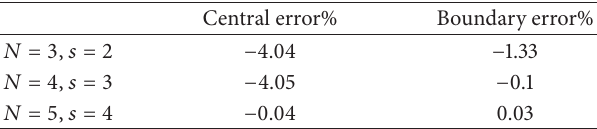
Table 1: Central ( 𝑥 = 0 ; 𝑦 = 0 ) and boundary ( 𝑥 = 0 ; 𝑦 = 1 ) error relative to the maximum deflection of the membrane of unit